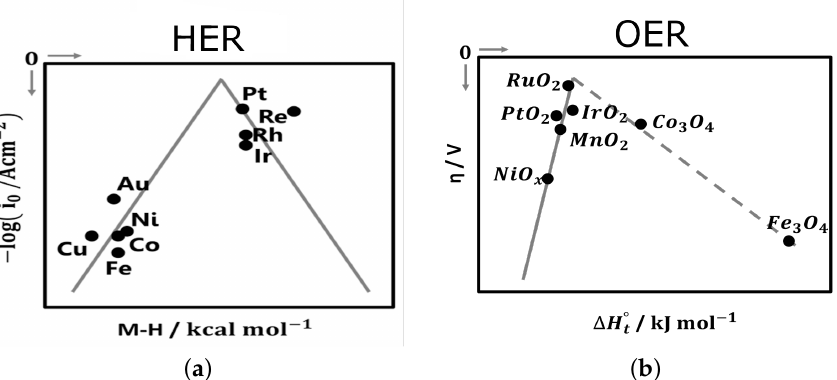
Figure 3. ( a ) Volcano plot for HER, exchange current density plotted against metal-H binding energy. ( b ) Volcano plot for OER, overpotential for OER versus the enthalpy of the oxide transition. Modified from [31] and [68],